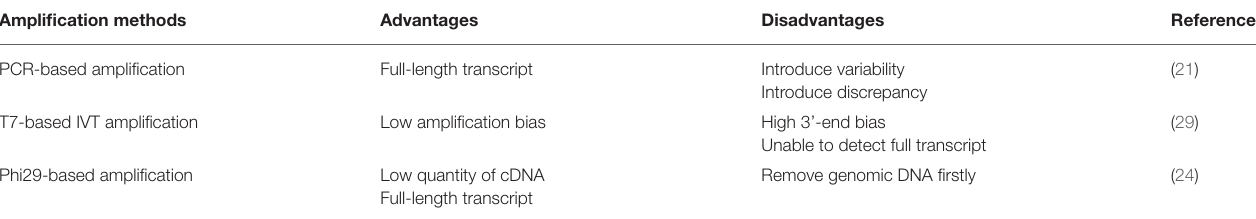
TABLE 2 | The advantages and disadvantages of three main single-cell cDNA amplification